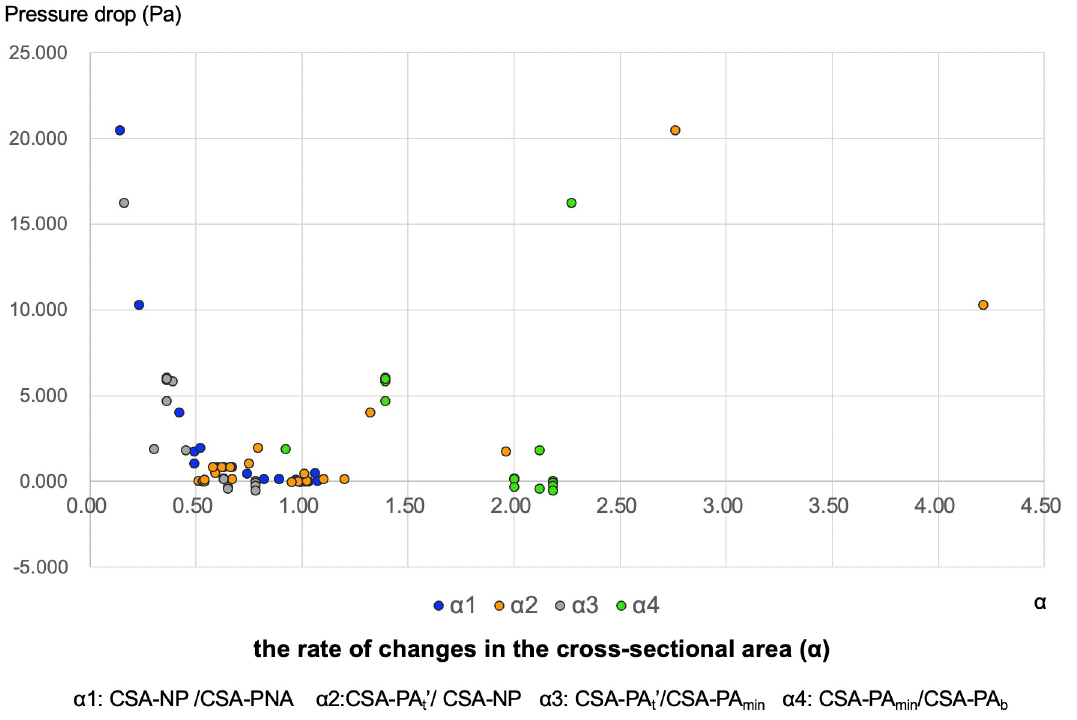
Fig 9. Pressure drop and the rate of changes in the cross-sectional area ( α ). Correlation between pressure drop and α . The horizontal axis indicates α and the vertical axis represents the pressure drop. Notes: blue, α 1; orange, α 2; grey, α 3; green, α 4.